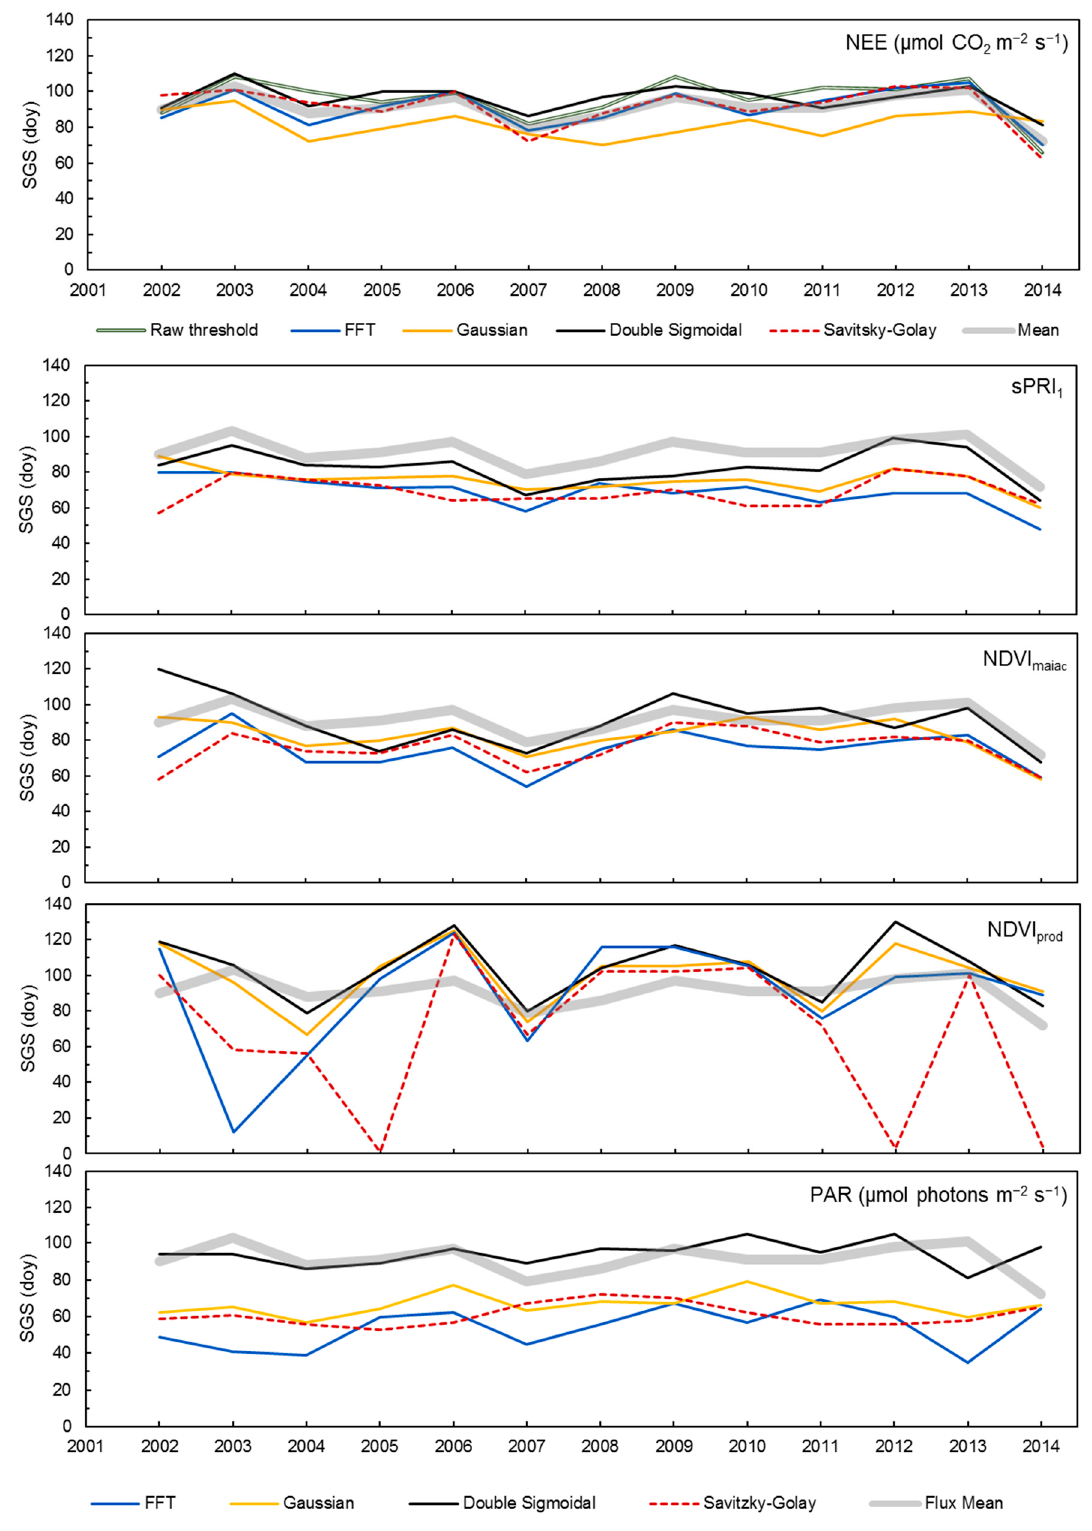
Figure 3. Estimated start of growing season (SGS) based on daily Net Ecosystem Productivity (NEE), the three different MODIS vegetation index time series (NDVI maiac , sPRI 1 and NDVI prod ) and ground-measured photosynthetically active radiation (PAR).